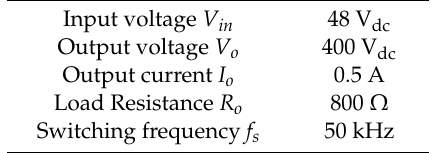
Table 1. Specification of the proposed converter.